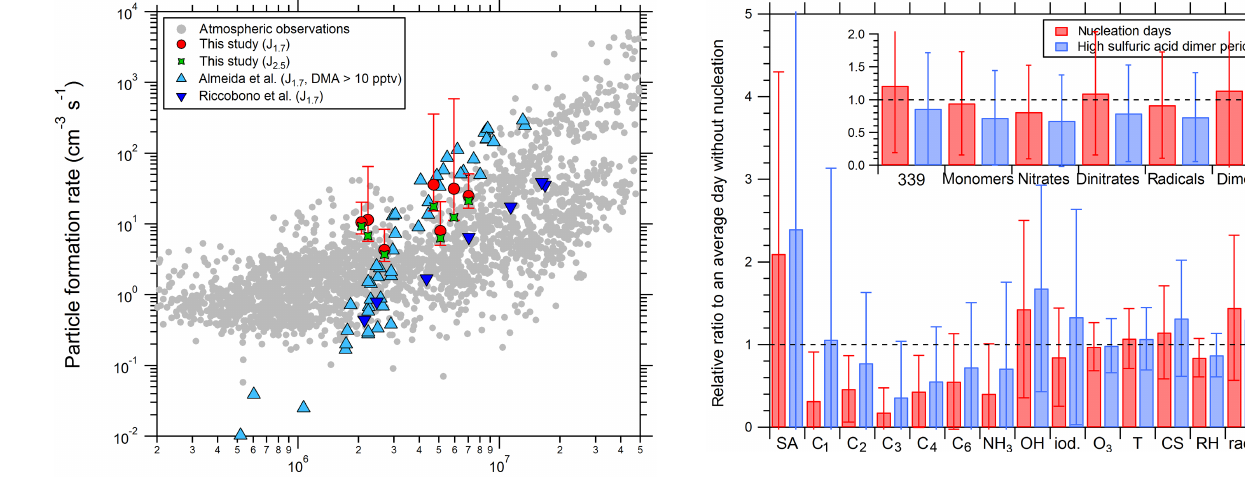
Figure 10. Comparison of various parameters for different time pe- riods (SA: sulfuric acid monomer; C 1 , C 2 , C 3 , C 4 and C 6 : amines; iod.: iodic acid; and rad.: global radiation intensity). The subset figure on the upper right shows the signals for the highly oxi- dized organic compounds with 10 or 20 carbon atoms (339: or- ganic compound C 10 H 15 NO 8 clustered with NO − having a mass 3 of 339.0681Th; the definition of other HOMs, i.e., monomers, rad- icals, nitrates, dinitrates and dimers, can be found in Table 2). The red bars relate nucleation days to days without nucleation and the blue bars show the ratio between periods where high sulfuric acid dimer concentrations were observed (see Fig. 6) to no-nucleation days. Similar times of the day (early morning) were used as refer- ence periods when no nucleation was observed as nucleation and dimer formation was also mainly observed in the